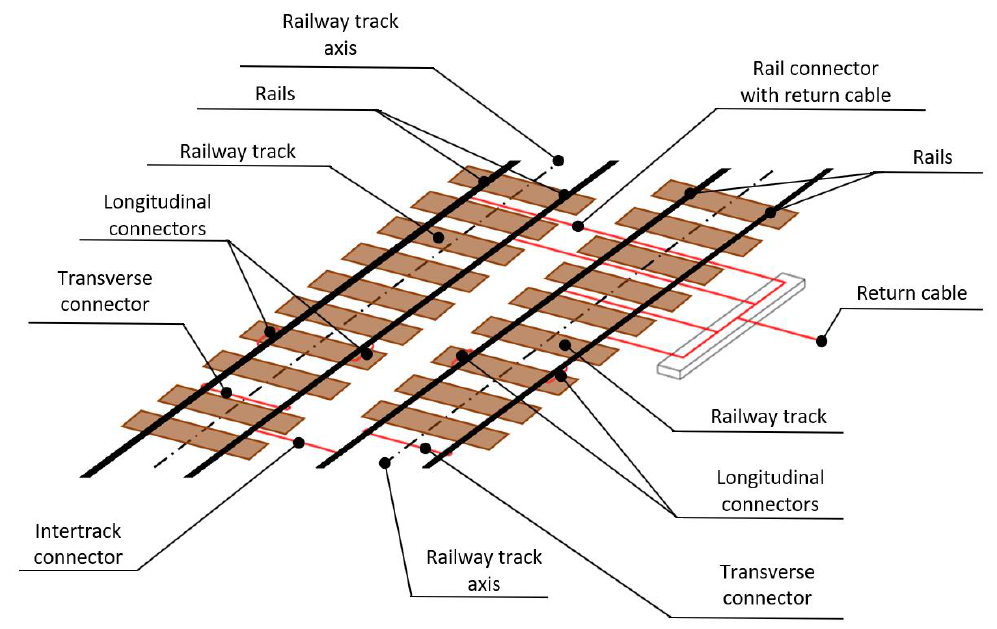
Figure 2. Connection scheme in the return network.